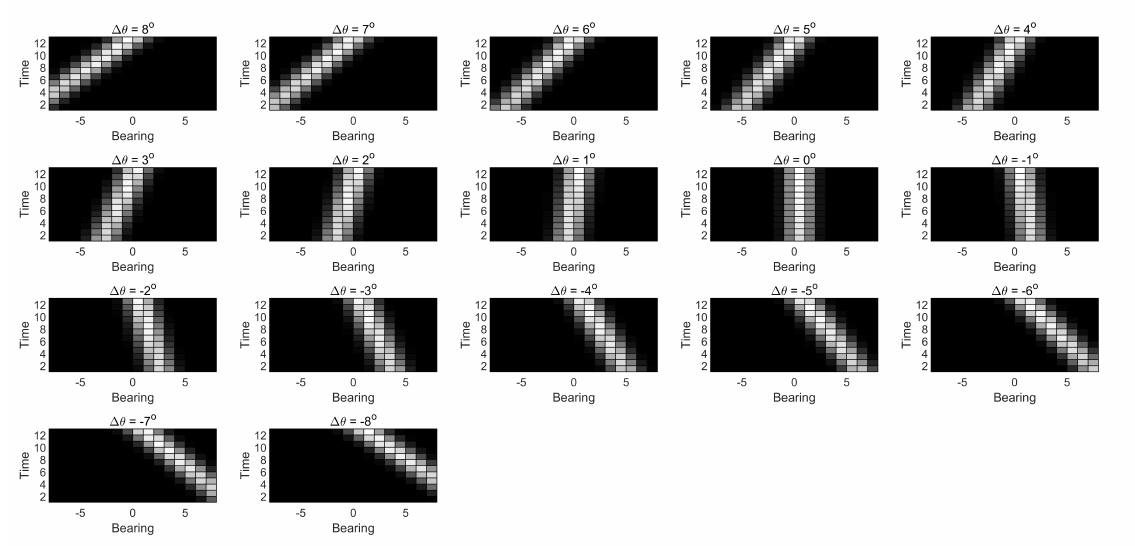
Figure 4. Gabor template library.